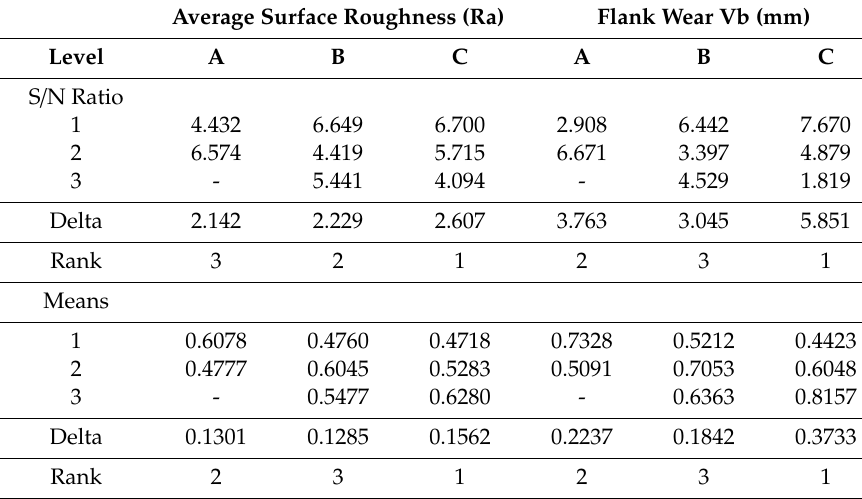
Table 7. Response table of S / N ratios and mean